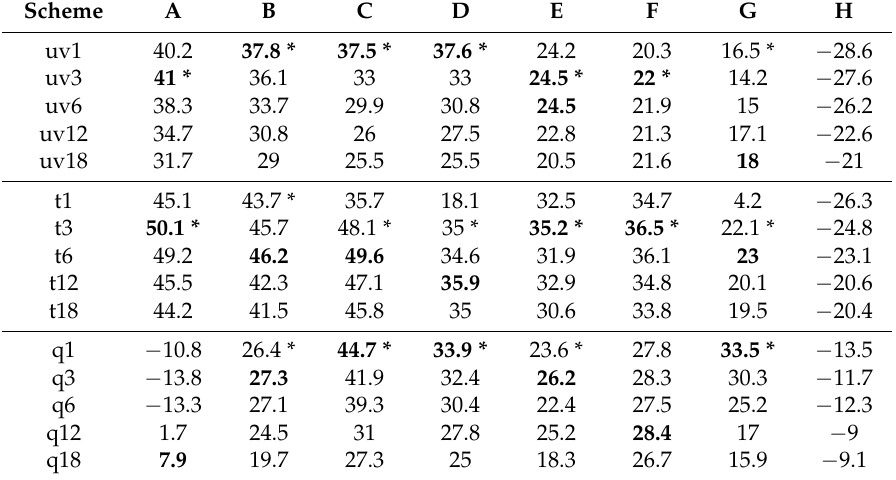
Table 6. Same as Table 2, except that the simulation results from 2009 were adopted (* denotes the optimum nudging time in 2010).